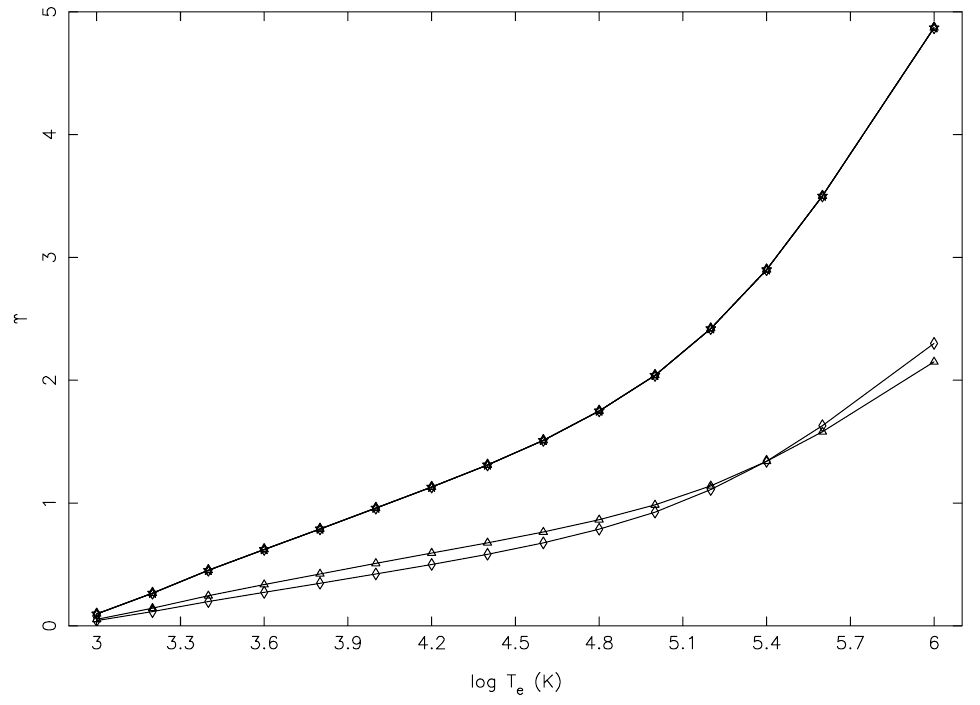
Figure 12. The BSR values of Υ by Tayal et al. [1] for the 14–198 ((triangles: 3s 2 3p3d 3 F o ( 2 P)3d 3 D 1 ), 19–198 (diamonds: 3s 2 3p3d 3 P o 3d 3 D 1 ) transitions of S